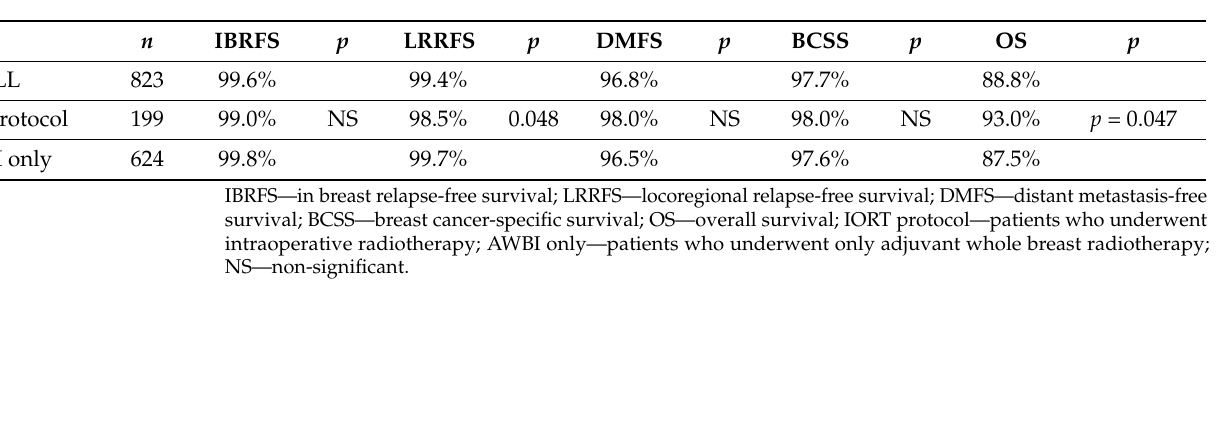
Table 1. Treatment results in the analyzed